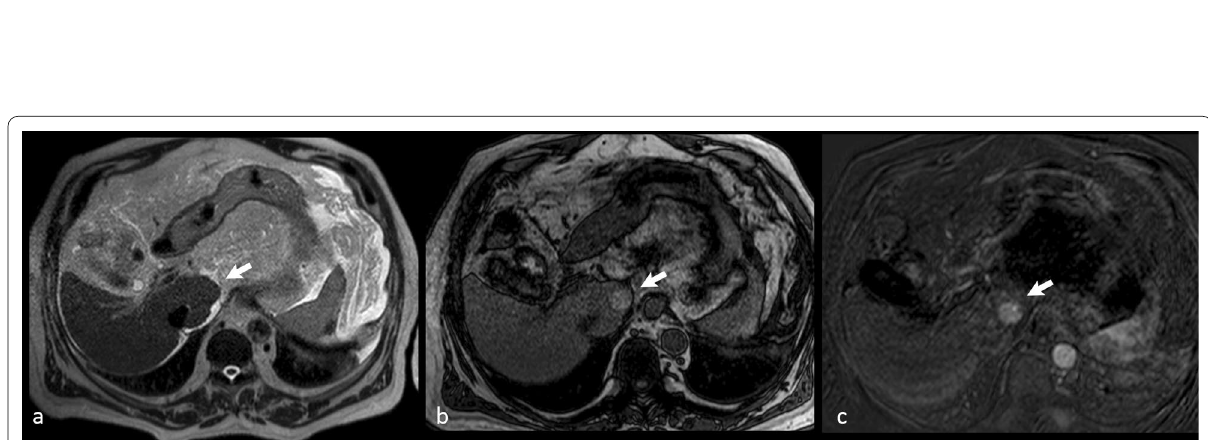
Fig. 7 Axial turbo spin echo (TSE) T2-w. image a of the abdomen does not show any focal lesion on the caudate lobe of the liver (arrow). On nonenhanced opposed-phase gradient echo (GE) T1-w. image b a well-defined hyperintense nodule (arrow) at the same level can be identified. Contrast-enhanced fat-saturated GE T1-w. scan in the arterial phase (obtained after subtraction of signal of nonenhanced image) ( c ) shows distinct contrast-enhancement of the lesion (arrow). Final diagnosis was low-grade hepatocellular carcinoma